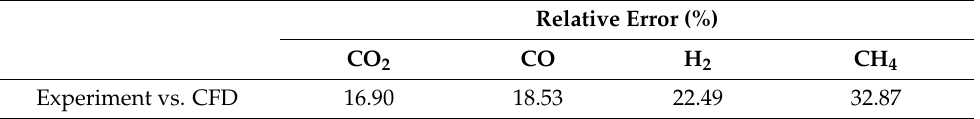
Experiment vs. CFD Table 9. Relative error analysis of CH 4 , CO 2 , CO and H 2 concentrations between average values obtained from CFD model and laboratory tests for the coal sample from hard coal mine B.